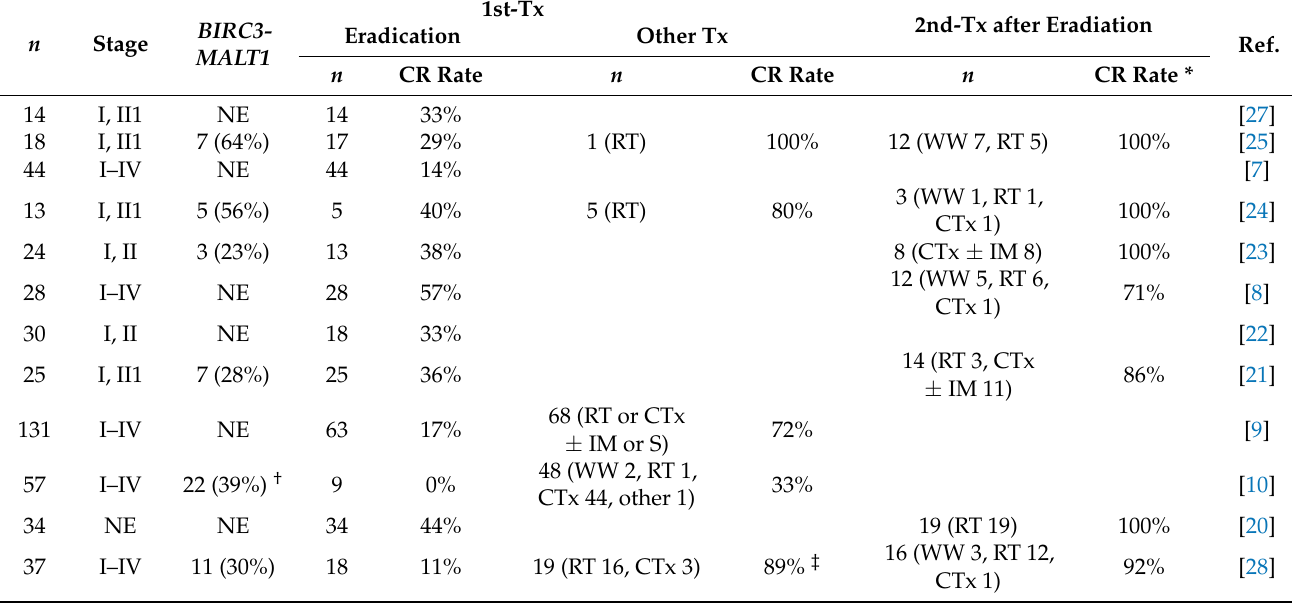
Table 1. H. pylori -negative patients with gastric MALT